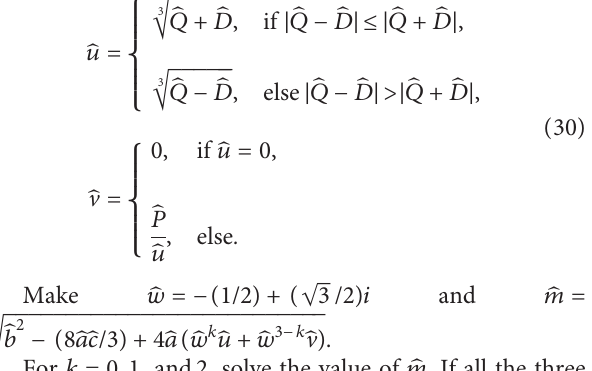
According to the visualization in Figure 1, max q ∗